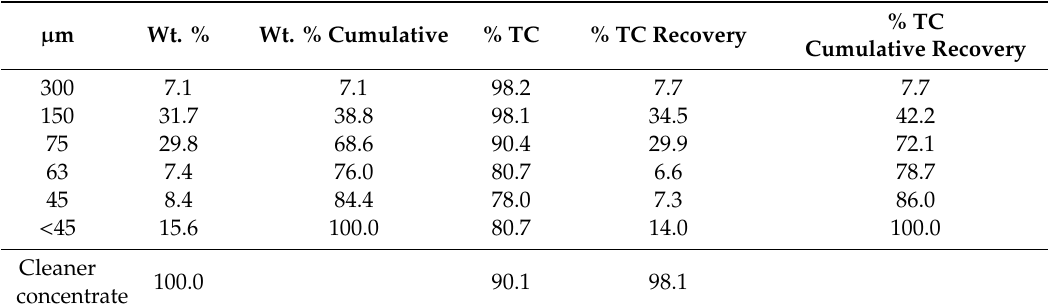
Table 2. Weight fraction (in % and cumulative), % TC recovered, % TC, and cumulative recovered, in cleaner concentrate (bottom row), from bench-scale beneficiation trials in [52]. In the size fractions > 150 µ m the highest purity flakes (highest TC) are